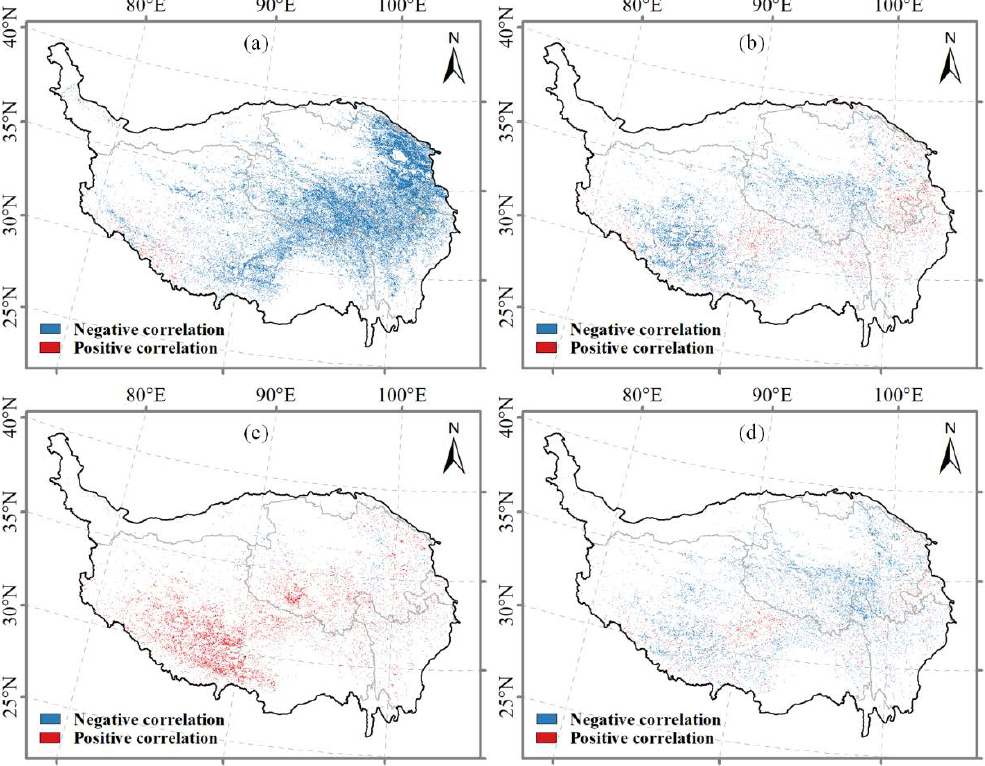
Figure 4. Spatial pattern displaying the correlations between beginning of growing season (BGS) and net primary productivity (NPP) in ( a ) spring, ( b ) summer, ( c ) autumn and ( d ) the entire year. Only significant correlations ( p < 0.05) are shown.